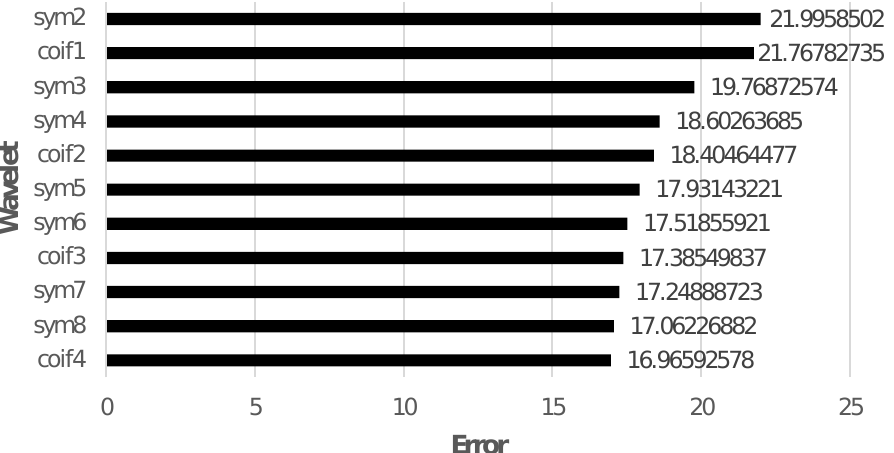
Figure 3. RMSE for the reconstructed signals using Level 9 detail coefficient of different